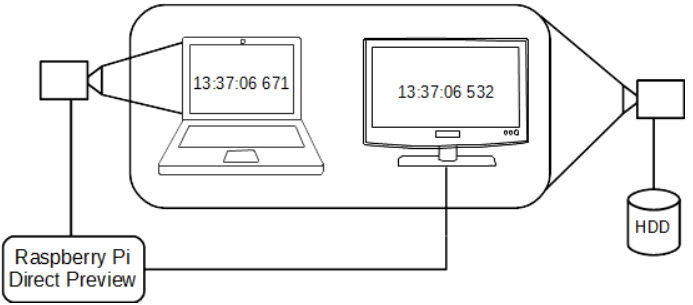
Figure 3. Measurement setup for capturing